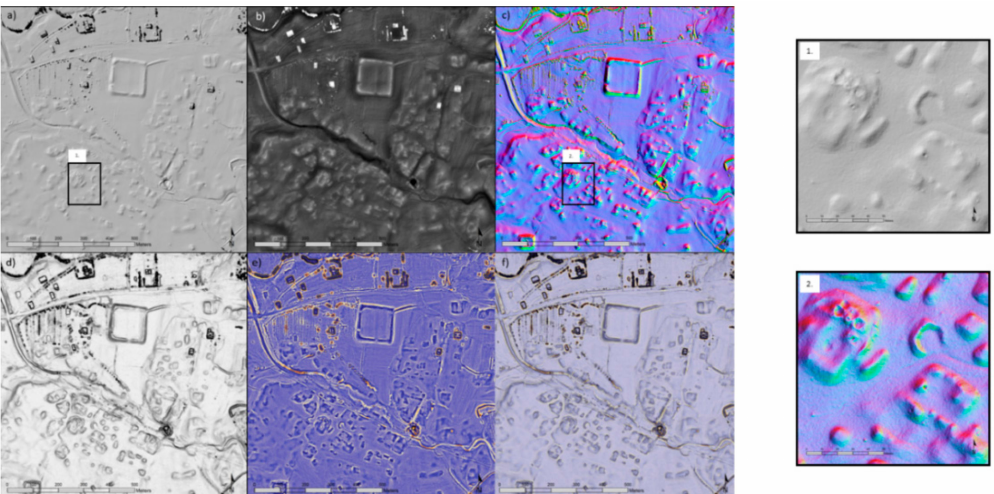
Figure 12. The application of airborne laser scanning visualization to the remote sensing dataset: ( a ) Shaded relief; ( b ) digital di ff erential model; ( c ) Principal Component Analysis (PCA) analyses; ( d ) Sky-view factor; ( e ) Local Relief Model; ( f ) optimal output based on the combination of the Local Relief Model and Sky-view factor. On the right is a comparison of the feature visibility of PCA analyses ( 2 ) (99% of the entire information extracted from the whole image) with that of the basic hillshade mode ( 1 ) (author: Lenka Starkov á